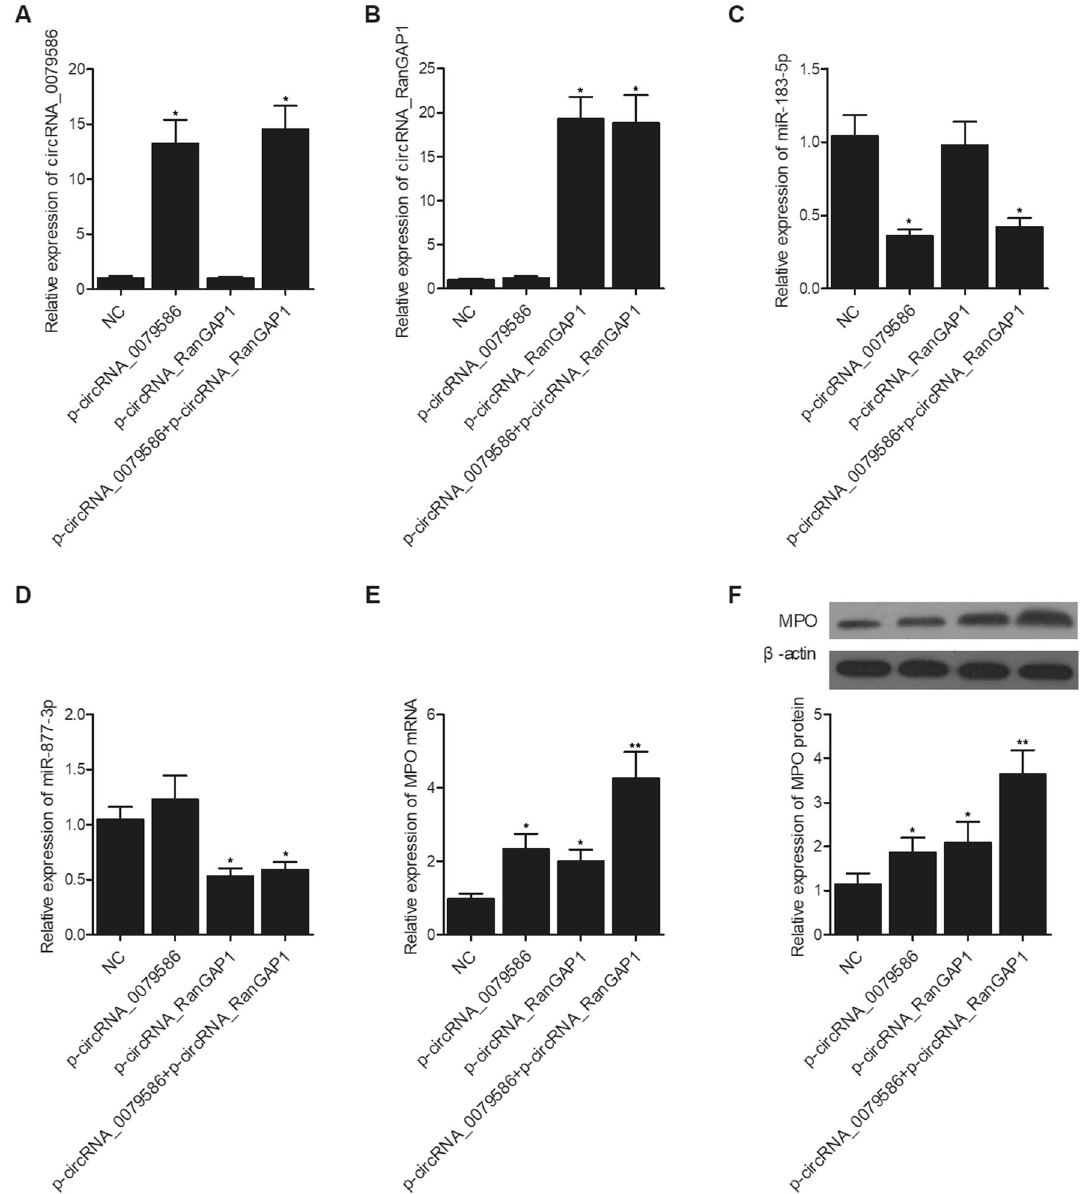
Figure 5. Overexpression of circRNA_0079586 and circRNA-RanGAP1 suppressed the expression of miR-183-5p and miR-877-3p, respectively, and activated the expression of MPO in HUVECs. ( A ) The expression of circRNA-0079586 was dramatically enhanced in HUVECs transfected with p-circRNA-0079586 and p-circRNA_0079586 + p-circRNA_RanGAP1 (* P < 0.05 vs. NC). ( B ) The expression of circRNA- RanGAP1 was dramatically enhanced in HUVECs transfected with p-circRNA-RanGAP1 and p-circRNA_0079586 + p-circRNA_RanGAP1 (* P < 0.05 vs. NC). ( C ) The expression of miR-183-5p was obviously suppressed in HUVECs transfected with p-circRNA-0079586 and p-circRNA_0079586 + p-circRNA_ RanGAP1 (* P < 0.05 vs. NC). ( D ) The expression of miR-877-3p was apparently suppressed in HUVECs transfected with p-circRNA-RanGAP1 and p-circRNA_0079586 + p-circRNA_RanGAP1 (* P < 0.05 vs. NC). ( E ) The expression of MPO mRNA was significantly increased in HUVECs transfected with p-circRNA-0079586 or p-circRNA_RanGAP1 alone, and to a higher extent in HUVECs transfected with p-circRNA_0079586 + p-circRNA_RanGAP1 (* P < 0.05 vs. NC; ** P < 0.05 vs. p-circRNA_0079586). ( F ) The expression of MPO protein was significantly increased in HUVECs transfected with p-circRNA-0079586 or p-circRNA_RanGAP1 alone, and to a higher extent in HUVECs transfected with p-circRNA_0079586 + p-circRNA_RanGAP1 (* P < 0.05 vs. NC; ** P < 0.05 vs.